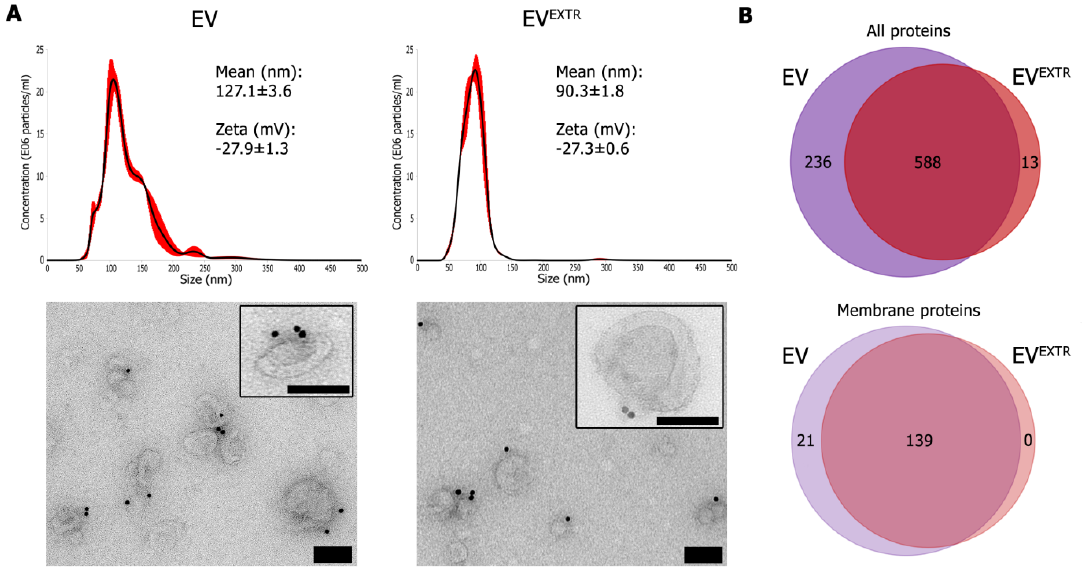
Figure 3. Mechanical extrusion does not significantly alter EV physical and biochemical characteristics. ( A ) Upper panels: NTA size distribution of EV versus extruded EV, depicted as mean (black line) with standard error (red shaded area). Inset: mean size ± standard error; mean zeta potential ± standard error. Lower panels: CD9 immuno-electron microscopy images of EV versus extruded EV. Scale bars: 100 nm. ( B ) Venn diagrams of proteins identified by mass spectrometry in EV versus extruded EV, including either all proteins (upper diagram) or proteins annotated as membrane proteins (lower diagram).